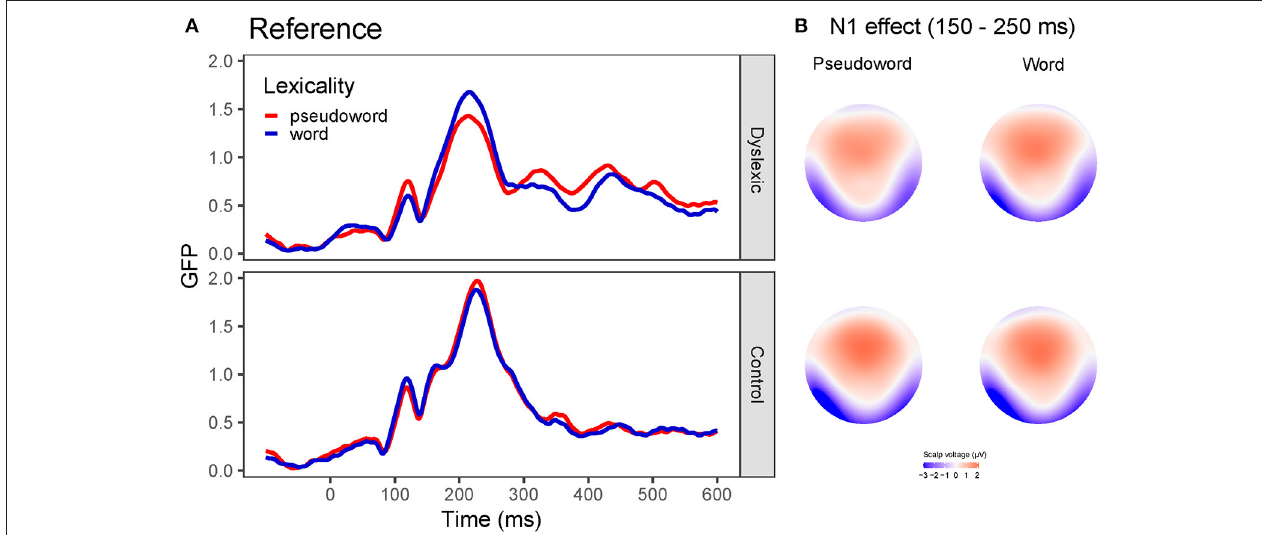
FIGURE 3 | Global field power (GFP) curves and topographic maps for the reference stimuli. Note that reference stimuli were always presented visually. (A) GFP for the word and pseudoword stimuli separately for the dyslexia and control group. (B) Topographic maps for the N1 effect for the word and pseudoword stimuli separately for the groups with and without dyslexia averaged between 150 and 250ms.